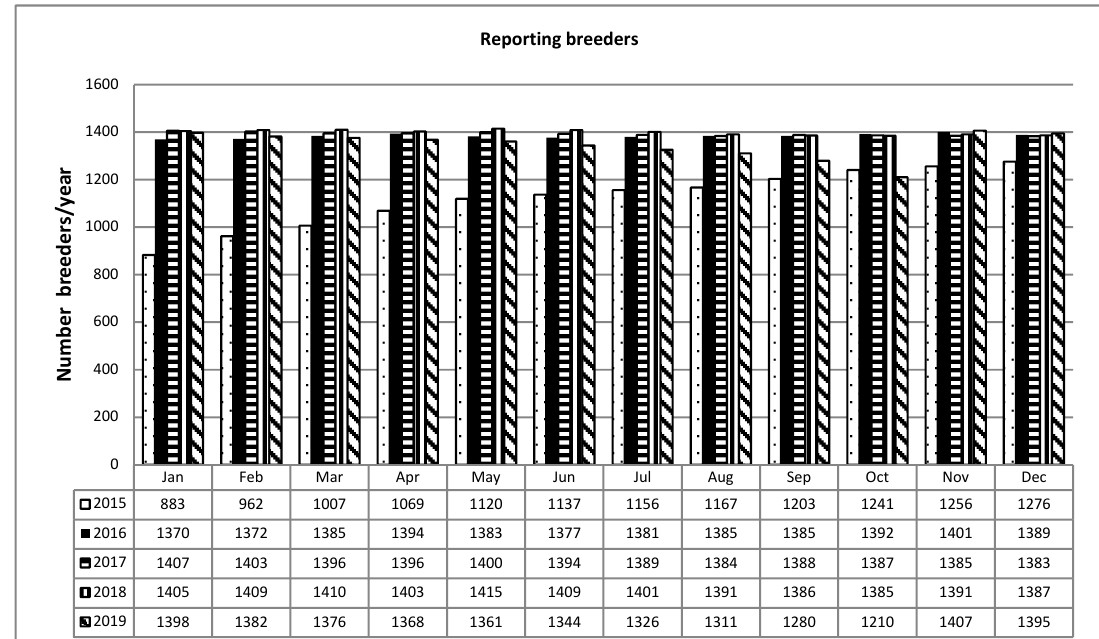
Figure 2. Reporting breeders.